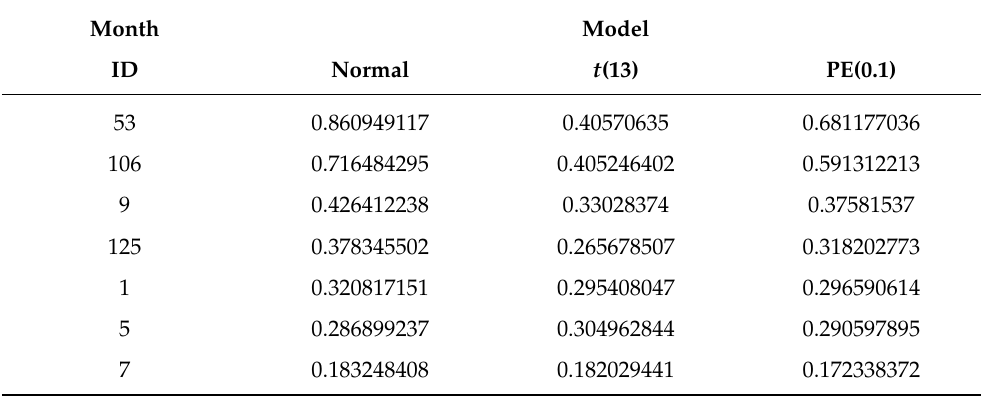
Table 9. Total local influence C h ( θ ) under case-weight perturbations influencing values in the indicated model with data of monthly